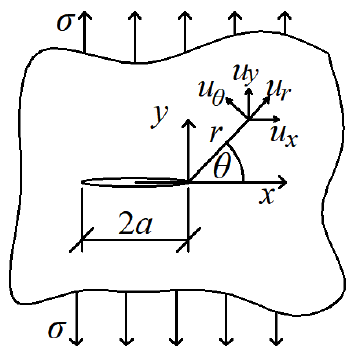
Figure 7. Displacements around Griffith’s crack.